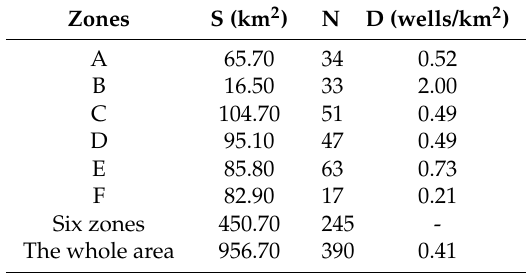
Table 1. Well densities of six zones and the whole study area.